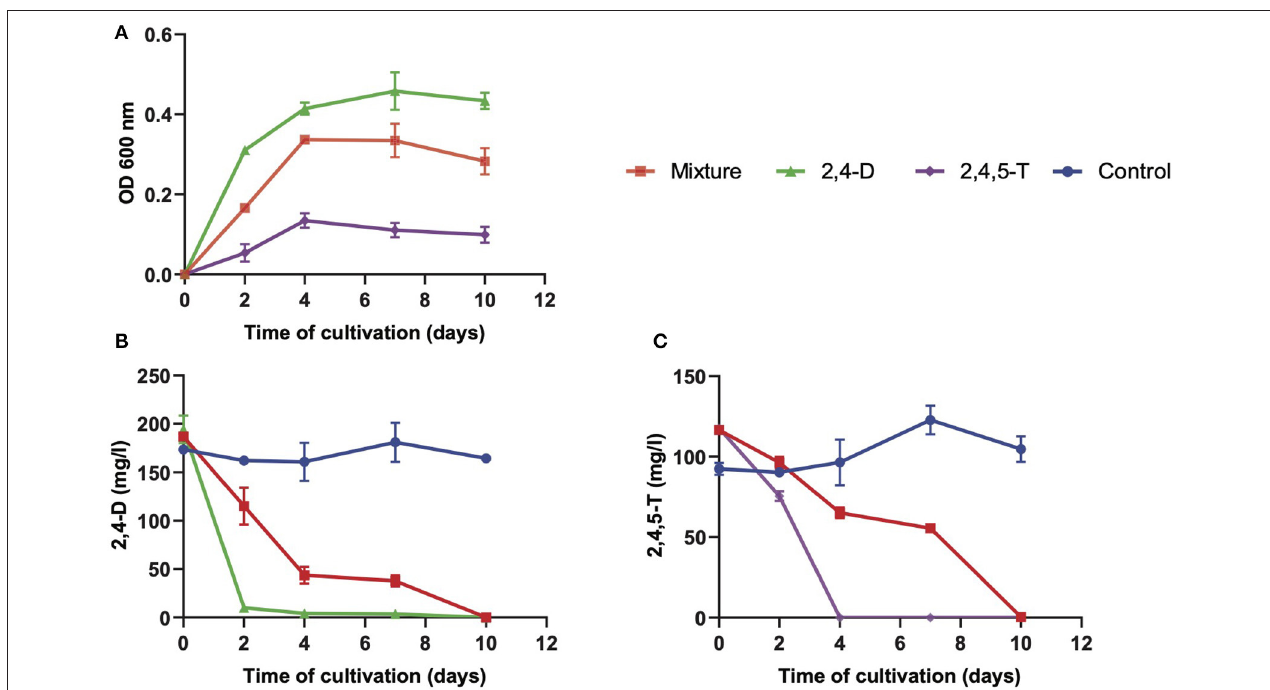
FIGURE 2 | Bacterial growth (A) , degradation of 2,4-D (B) , and degradation of 2,4,5-T (C) in mineral salt medium with either a mixture of 2,4-D and 2,4,5-T (mixture) or with only 2,4-D or 2,4,5-T as single herbicide inoculated with B. petrii BT1 9.2. Results are shown as averages of triplicate cultures, with the error bars representing standard deviations. The optical density (OD 600nm) at the start of each growth curve (an average of about 0.32 for all three types of culture) was subtracted from those further on in these curves.